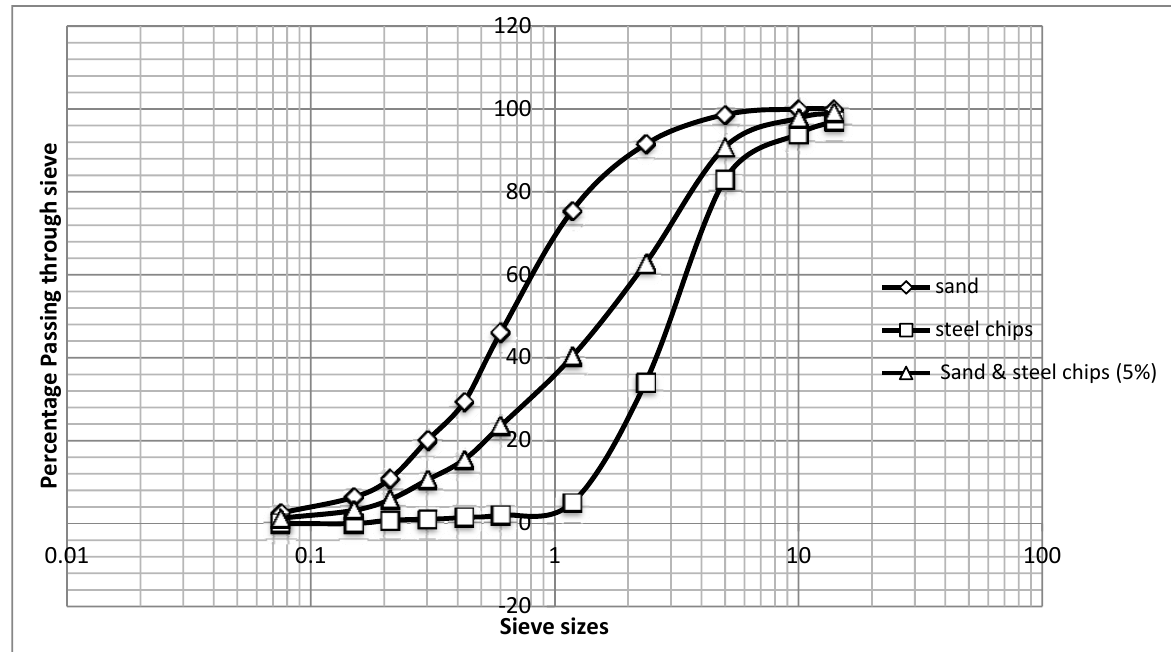
Figure 3. Grading curves for sand and steel chips (5%) combination.